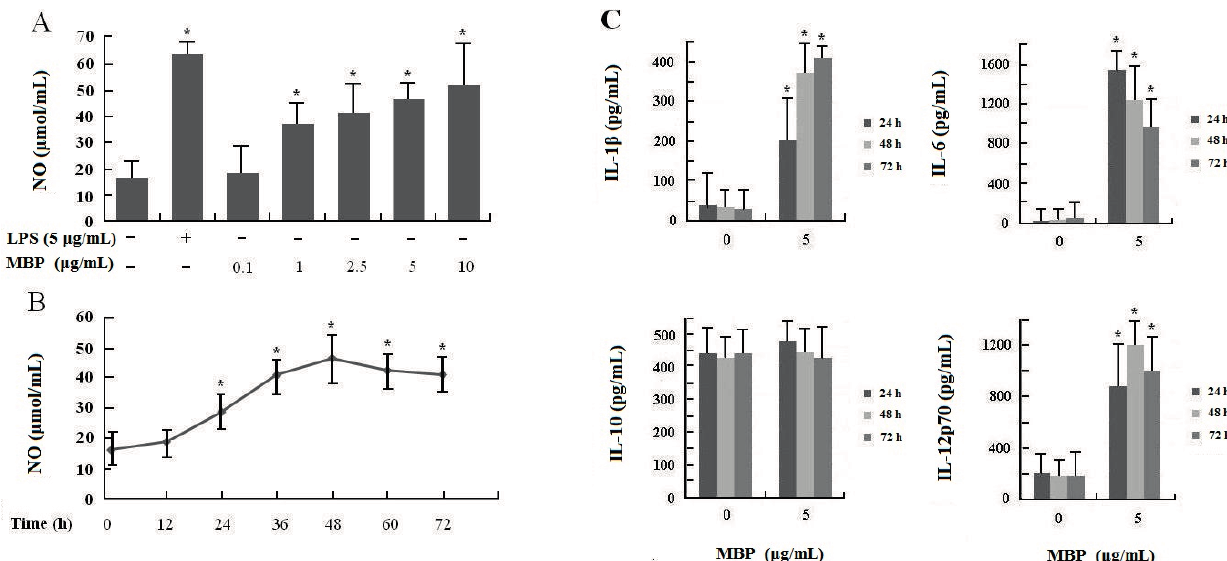
Figure 1. Effects of MBP on NO production and cytokine secretion in